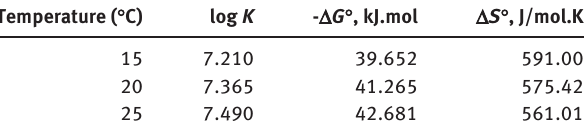
Figure 3 Continuous variation graph of adrenaline-iron(III) (1 × 10 -3 m ).